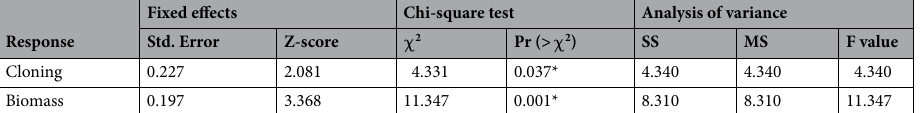
Table 1. Reproductive and productivity traits (cloning and aboveground biomass, respectively) from sky island populations (SI) have diverged from mountain chain populations (MC). Data refer to summary statistics for generalized linear mixed-effects and linear mixed-effects models, respectively, where cloning and biomass were predicted by SI and MC as a fixed effect, with watershed/genotype as a nested random effect. Asterisks indicate quantitative trait differences that are significantly different from zero (* p < 0.05).